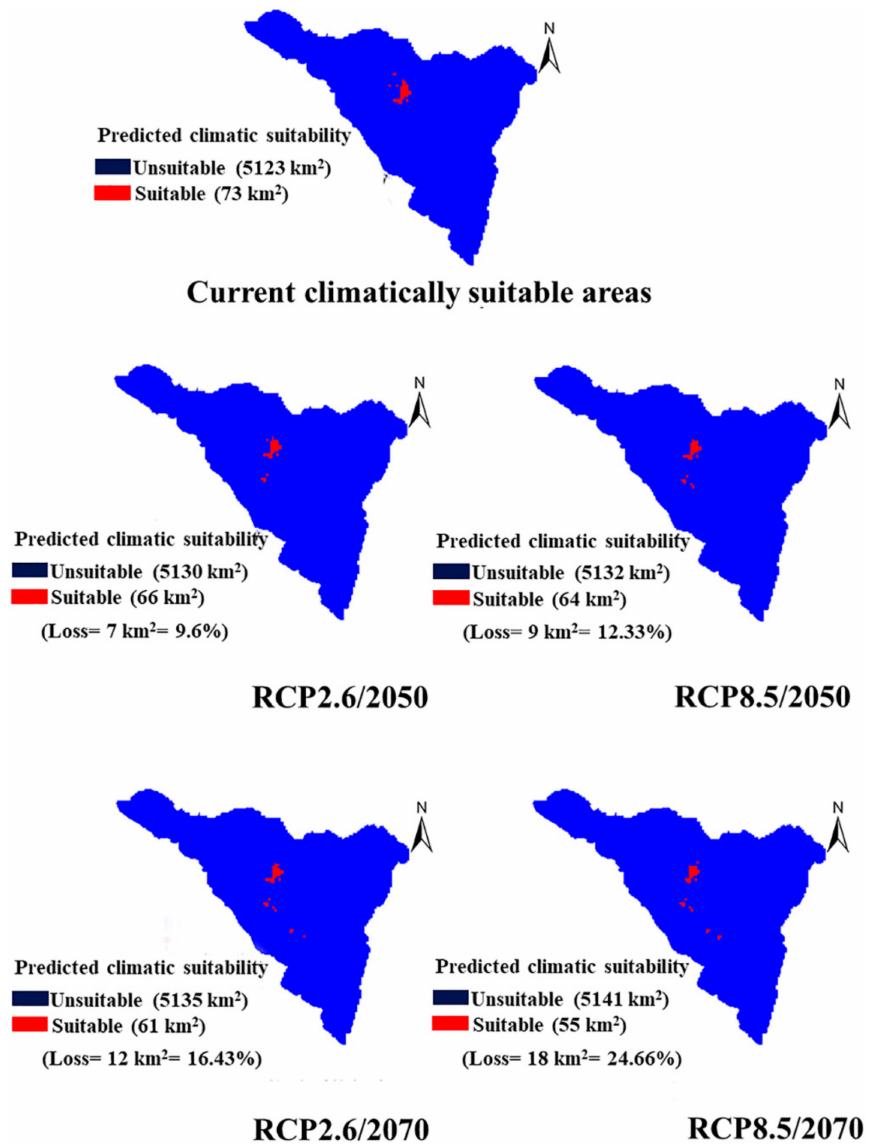
Figure 4. Future potential distribution area of P. boveana predicted for 2050 and 2070 under two representative concentration pathways (RCP2.6 and RCP8.5), compared with the current climatically suitable areas (binary predictive map of the climate-only model). The values in the figures represent the area (in km 2 ) of the suitable and unsuitable climatic areas, and the loss range (in both km 2 and